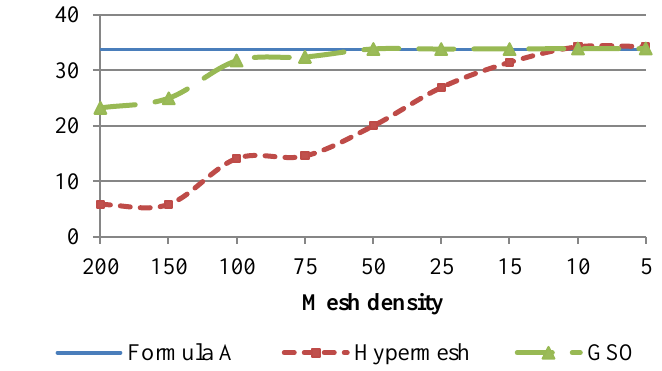
Figure 7. Mesh convergence and